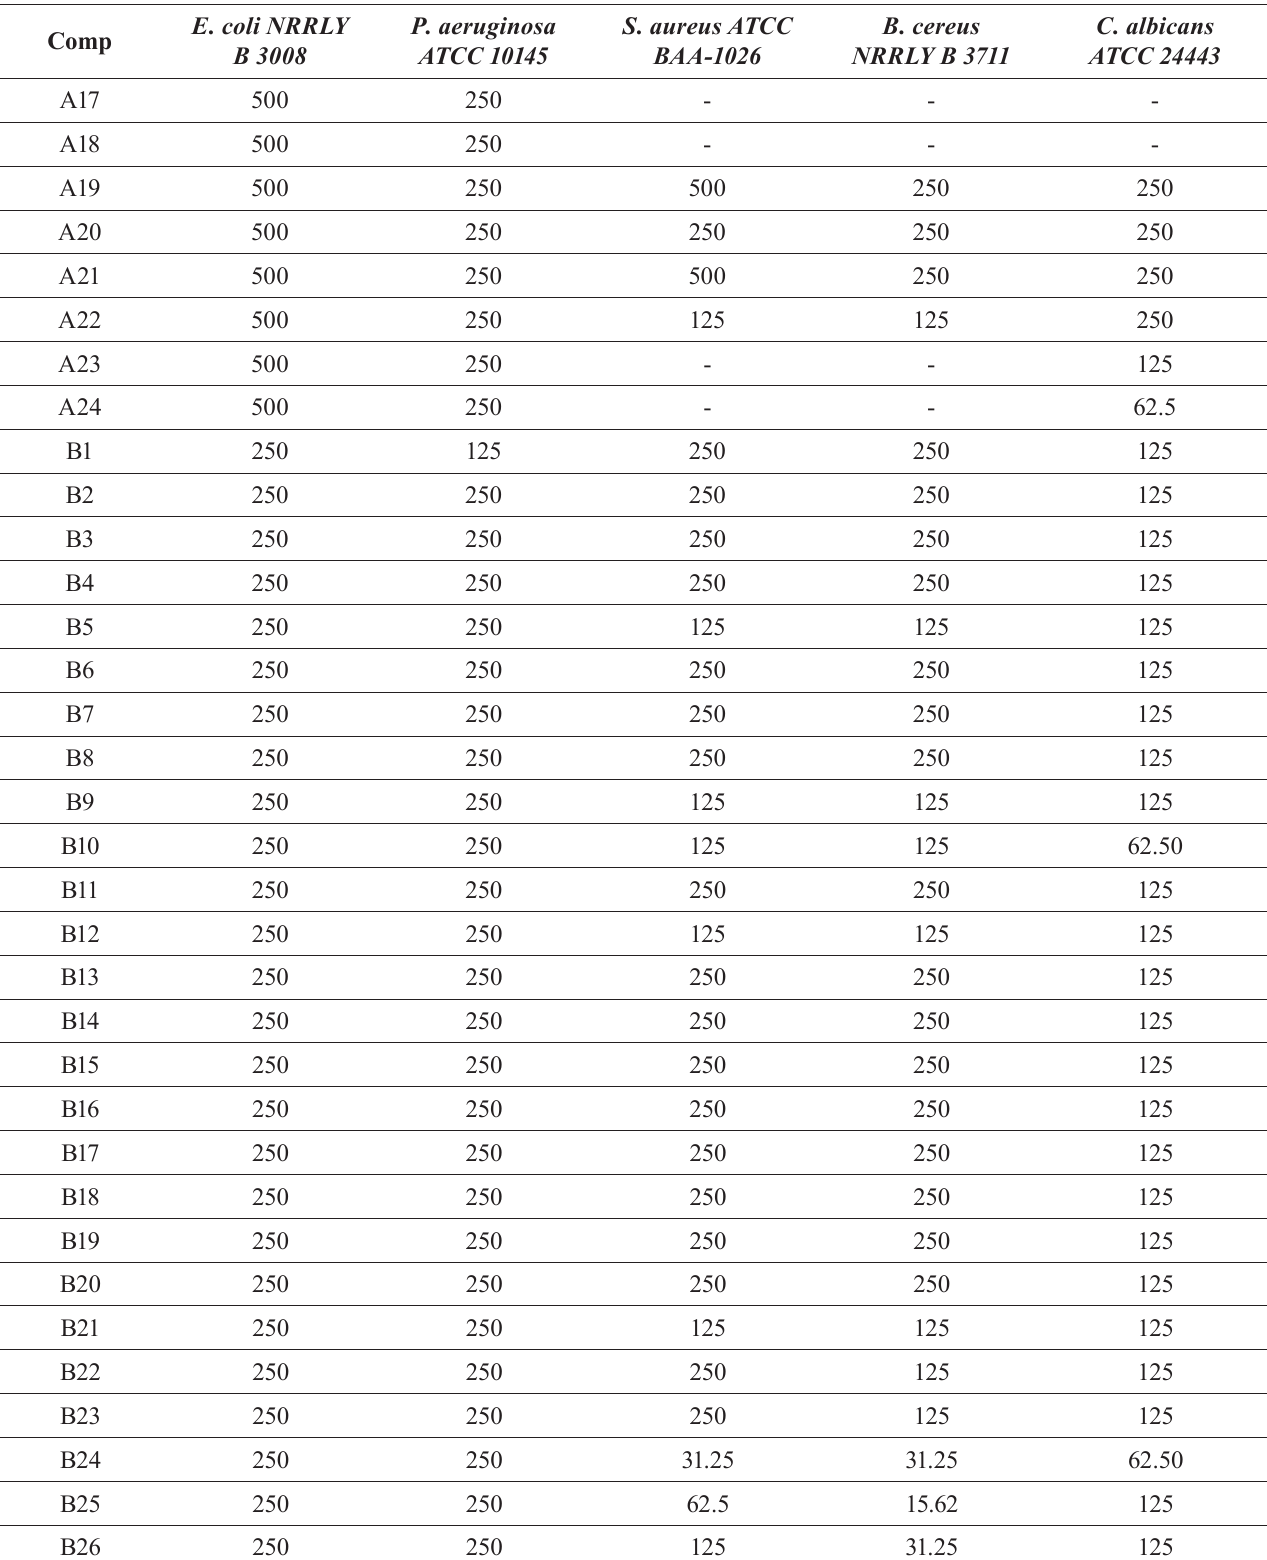
TABLE II – MIC (µg/mL) of the compounds series V(A1-A24, B1-B39)